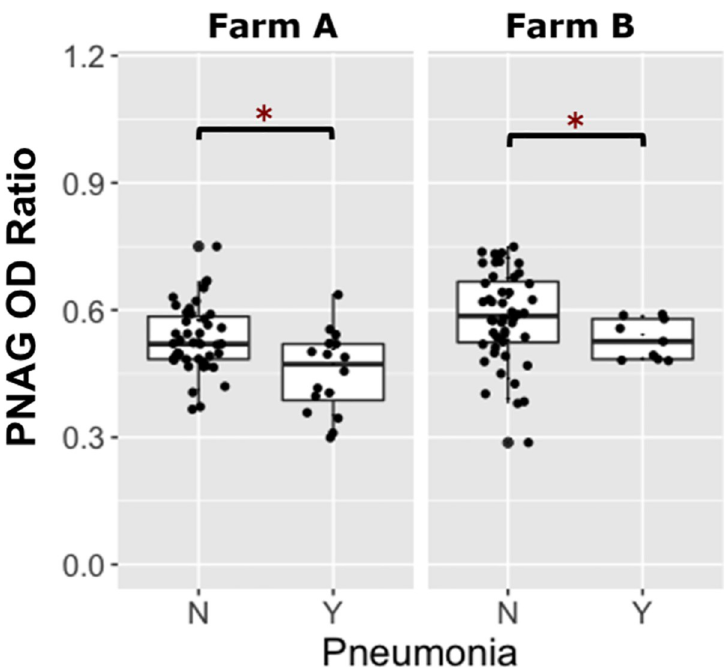
Fig 5. Foals transfused with PNAG hyperimmune plasma and their comparison of PNAG optical density ratios with whether they developed pneumonia or remained healthy. Boxplots of optical density (OD) ratios from ELISAs measuring deposition onto purified β -(1 ! 6)-linked poly- N -acetyl-glucosamine (PNAG) by serum antibodies in 116 foals transfused with PNAG hyperimmune plasma (PNAG HIP) stratified by pneumonia status, faceted by farm. Foals transfused with PNAG HIP at both farms that remained healthy (no pneumonia = ‘N) had significantly higher (asterisks represent P < 0.05) PNAG OD ratios than foals that developed pneumonia (pneumonia = ‘Y).